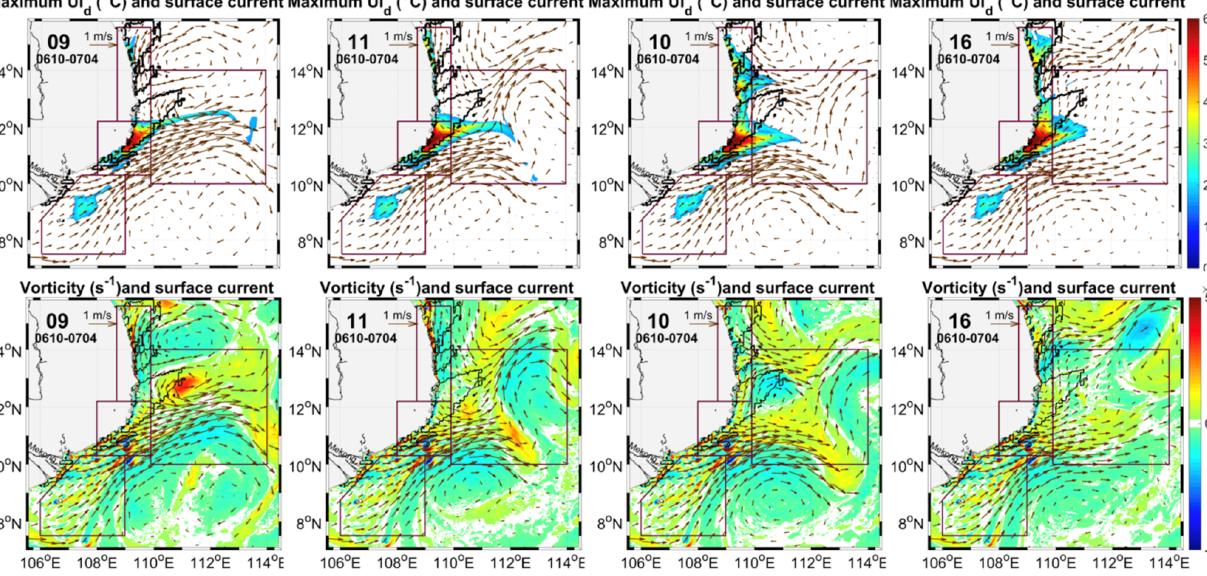
Figure 6. Maps of UI d (first row, ◦ C) on the day of maximum UI d , boxNC over the July wind peak period over boxNC (highlighted in green in Fig. 2) and maps of average surface current vorticity (second row, s − 1 ) for two members of weak NCU (9, 11) and two members of strong NCU (10, 16) during the June–July period. Black contours: 3.10 − 7 Nm − 3 iso-contours of average wind stress curl during each period. Arrows: average surface current (ms − 1